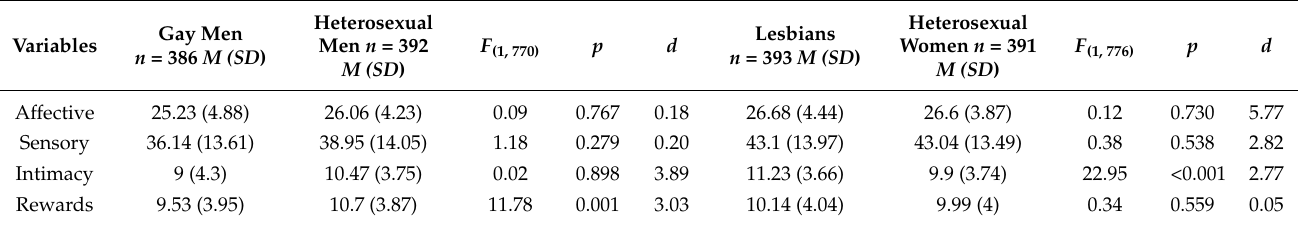
Table 5. Effects of sexual orientation on subjective orgasm experience.